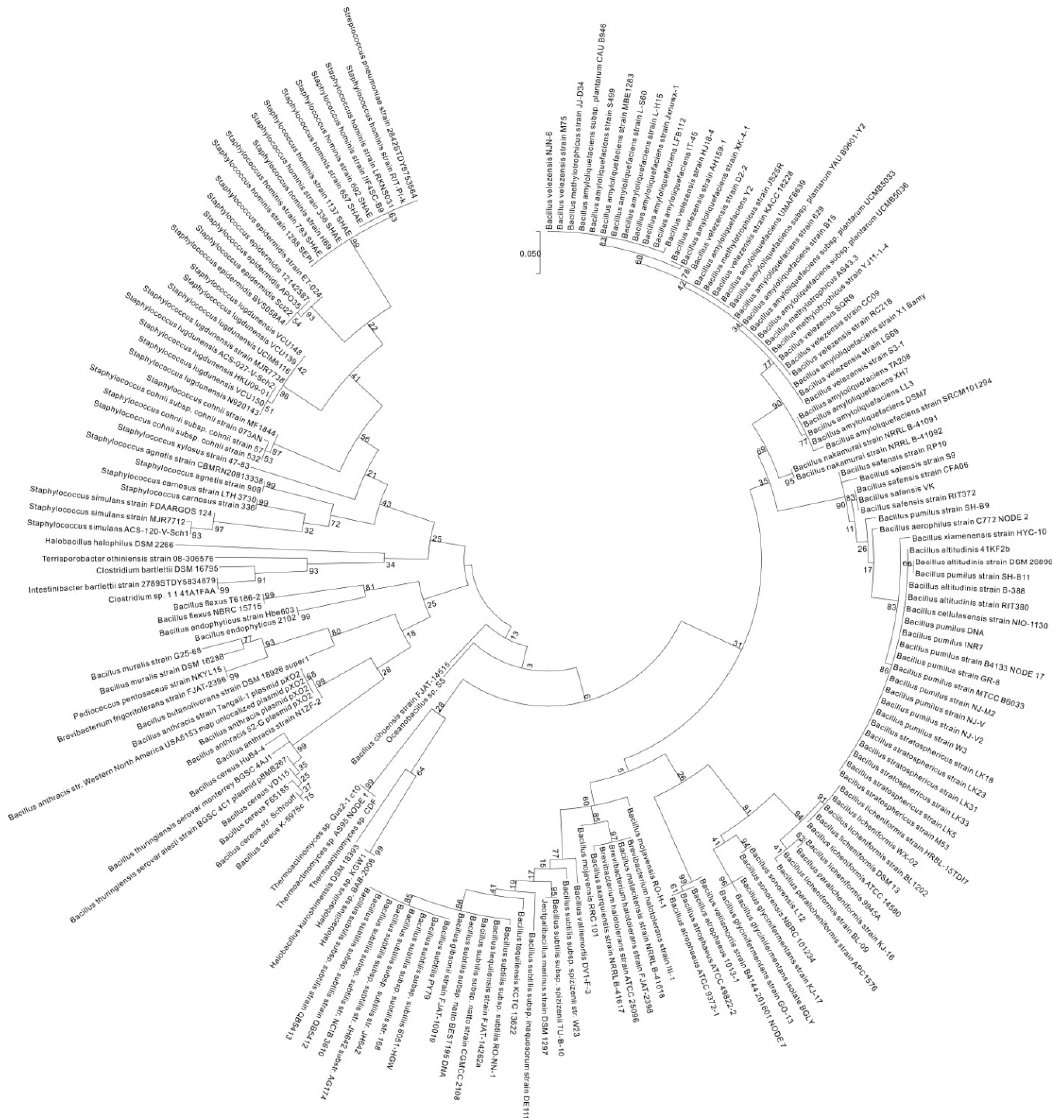
Figure 3. Molecular phylogenetic analysis of pgsB by the maximum likelihood method. The phylogenetic tree with branch lengths was measured as the number of substitutions per site. The analysis involved 192 nucleotide sequences. Partial deletion was used, and all positions with less than 95% site coverage were eliminated, i.e., less than 5% of the alignment gaps, instances of missing data, and ambiguous bases were allowed at any position. Scale bar: number of substitutions per site. Evolutionary analyses were conducted in MEGA7